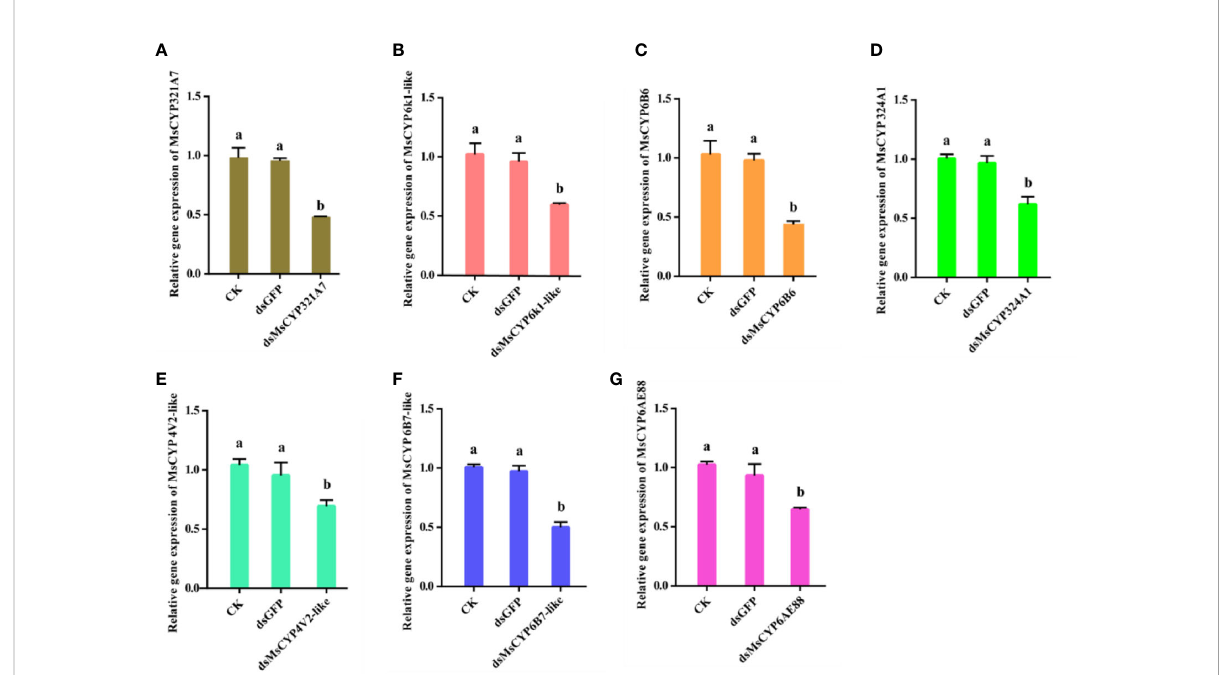
FIGURE 6 The relative gene expression levels of MsCYP450 genes after dsMsCYP450 gene treatment for 3 days. (From A – G , the genes are MsCYP321A7 , MsCYP6k1-like , MsCYP6B6 , MsCYP324A1 , MsCYP4V2-like , MsCYP6B7-like , and MsCYP6AE88 , respectively. Different lowercase letters above the bars indicate a signi fi cant difference (p < 0.05) based on one-way ANOVA followed by Tukey ’ s HSD test for multiple comparisons. Means ± SE from three replicates are